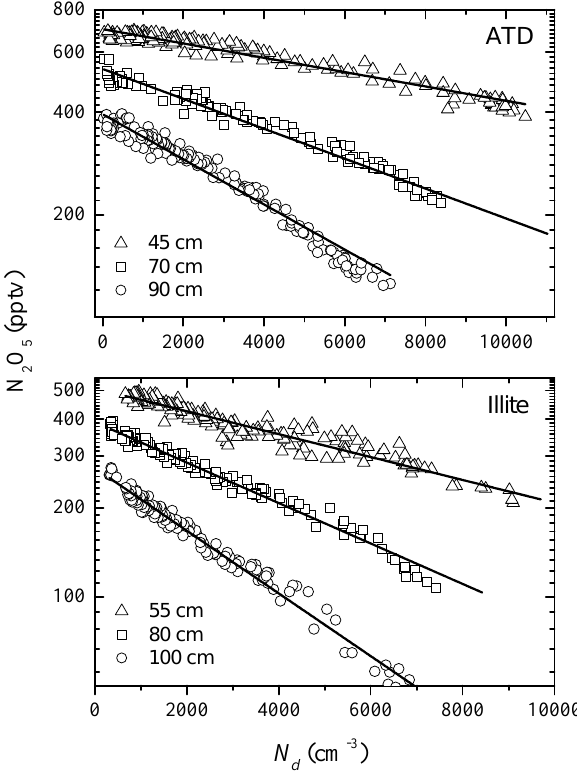
Fig. 4. Exponential dependence of the measured N 2 O 5 mixing ratio on the dust aerosol number concentration at three different injector positions at RH = 0%.